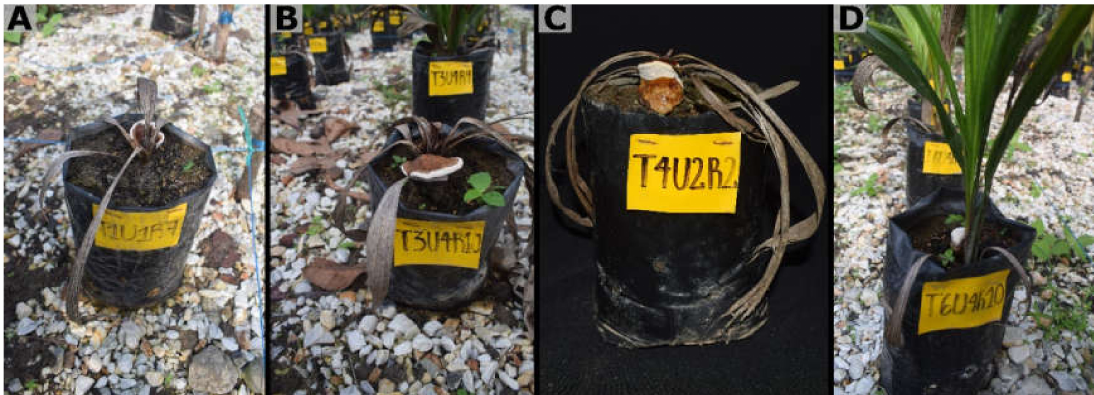
Figure 5. Seedlings inoculated with isolates of Ganoderma zonatum that presented the formation of basidiocarp. ( A ) CPBsZN-01-29. ( B ) CPBsZN-03-31. ( C ) CPBsZN-04-34. ( D ) CPBsZN-06-36.